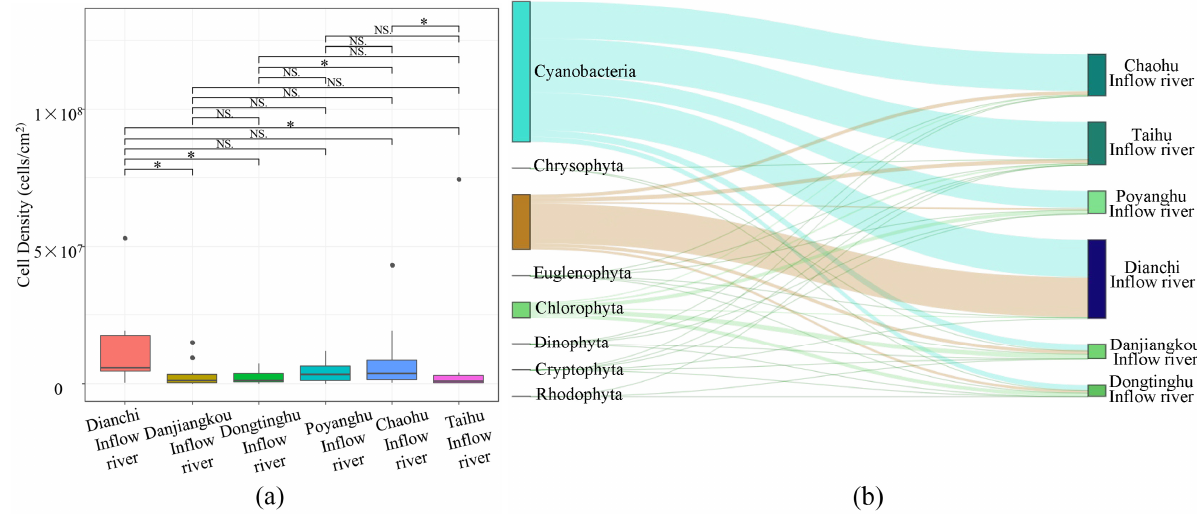
Figure 2. The cell density and community composition of periphytic algae in inflow rivers of six lakes. ( a ) Cell density; ( b ) Community composition. (* p < 0.05, and NS—not